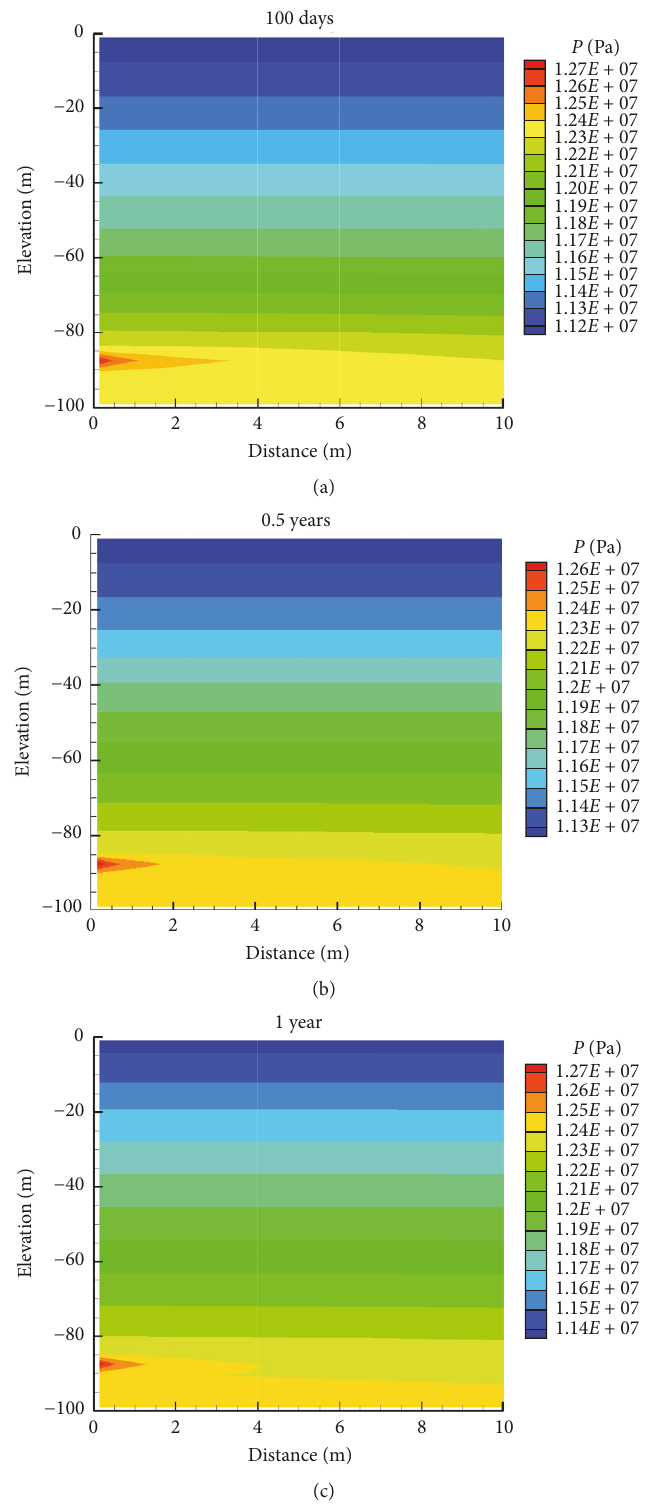
Figure 10: Contour map of fluid pressure ( 𝑃 ) near the injection well (pressure ( 𝑃 ) is observed in the range of 0 to 10 m, (a) after 100 days of CO 2 injection, (b) after half a year of CO 2 injection, and (c) after one year of CO 2